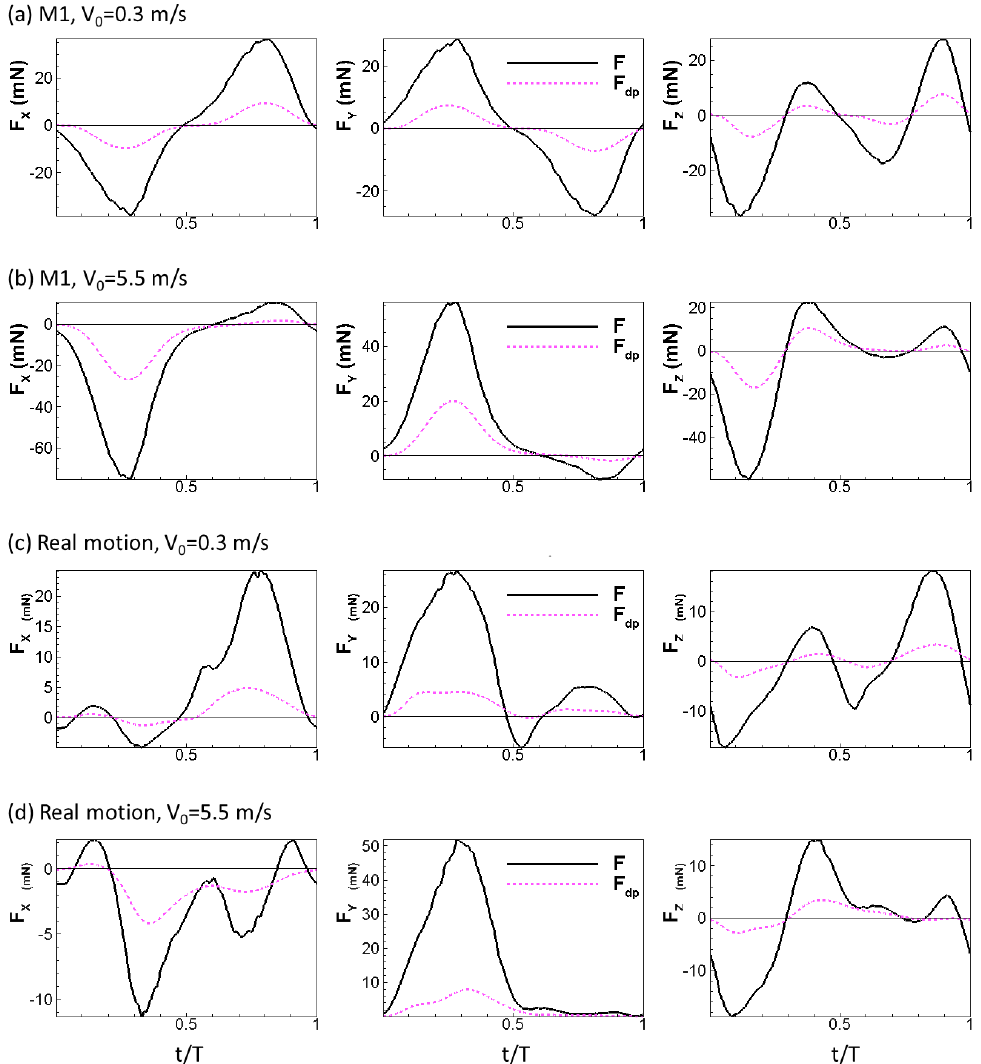
Figure 7. Aerodynamic forces of the wing compared to dynamic pressure force for the rigid model V = 0.3 m/s and 5.5 and the real model under 0